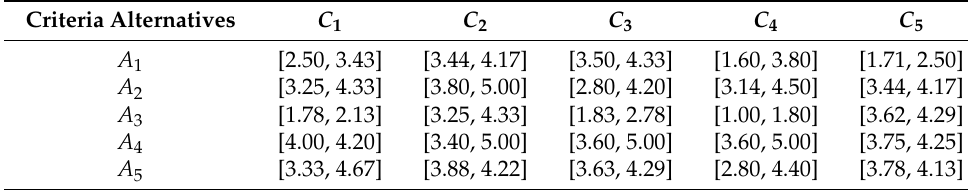
Table 10. Grey group decision-making matrix.